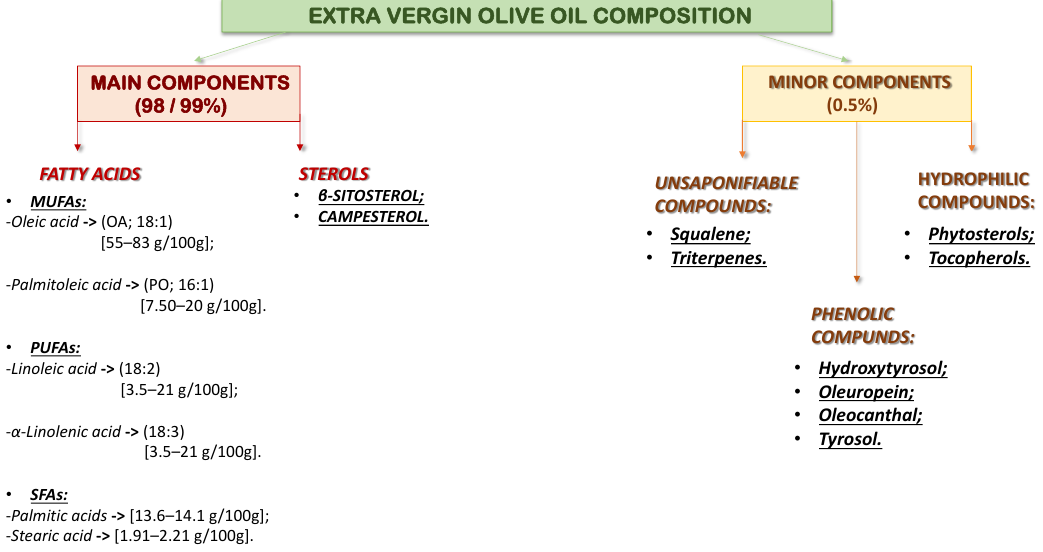
Figure 4. Extra virgin olive oil composition.